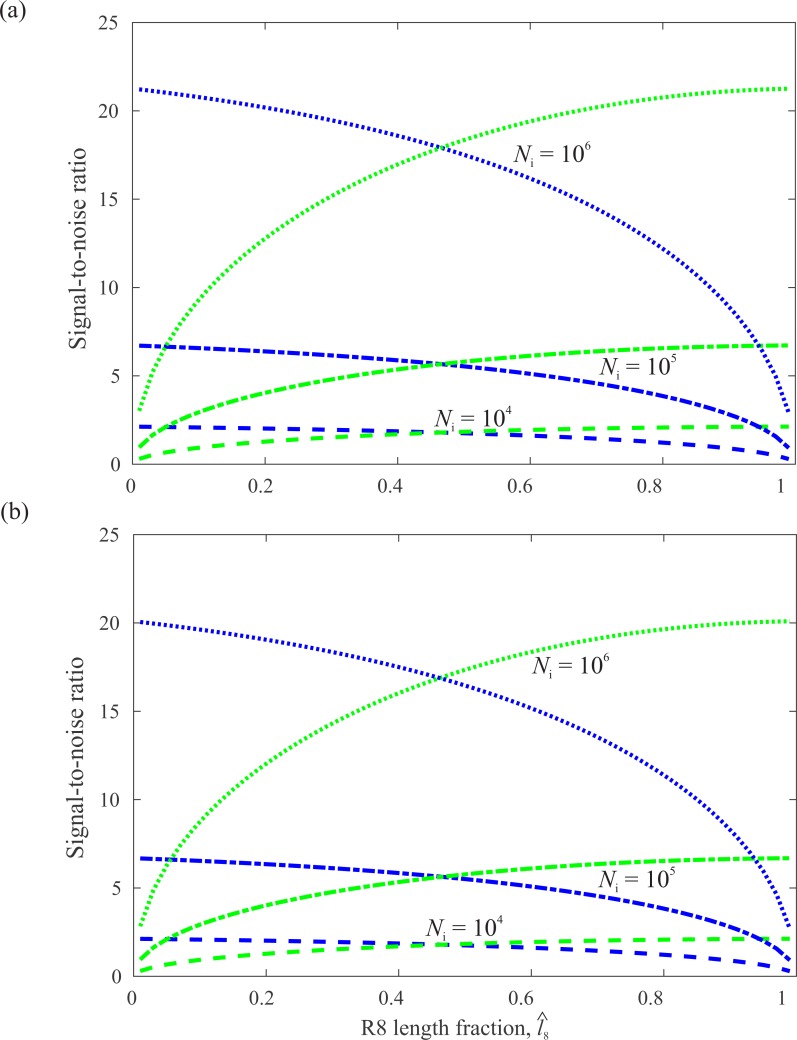
SNR in R7 (blue) and R8 (green) as a function of the fraction of the CRP occupied by R8, \documentclass[12pt]{minimal}
\usepackage{amsmath}
\usepackage{wasysym}
\usepackage{amsfonts}
\usepackage{amssymb}
\usepackage{amsbsy}
\usepackage{upgreek}
\usepackage{mathrsfs}
\setlength{\oddsidemargin}{-69pt}
\begin{document}
}{}$\hat {{l}_{8}}$\end{document}l8 ˆ, calculated for a CRP of fixed length l = 100µm at three light levels, Ni.(A) Calculated without modelling the saturation of transduction units. (B) Calculated with saturation. Saturation reduces SNR at the highest intensity. Degree of polarization d = 0.1.